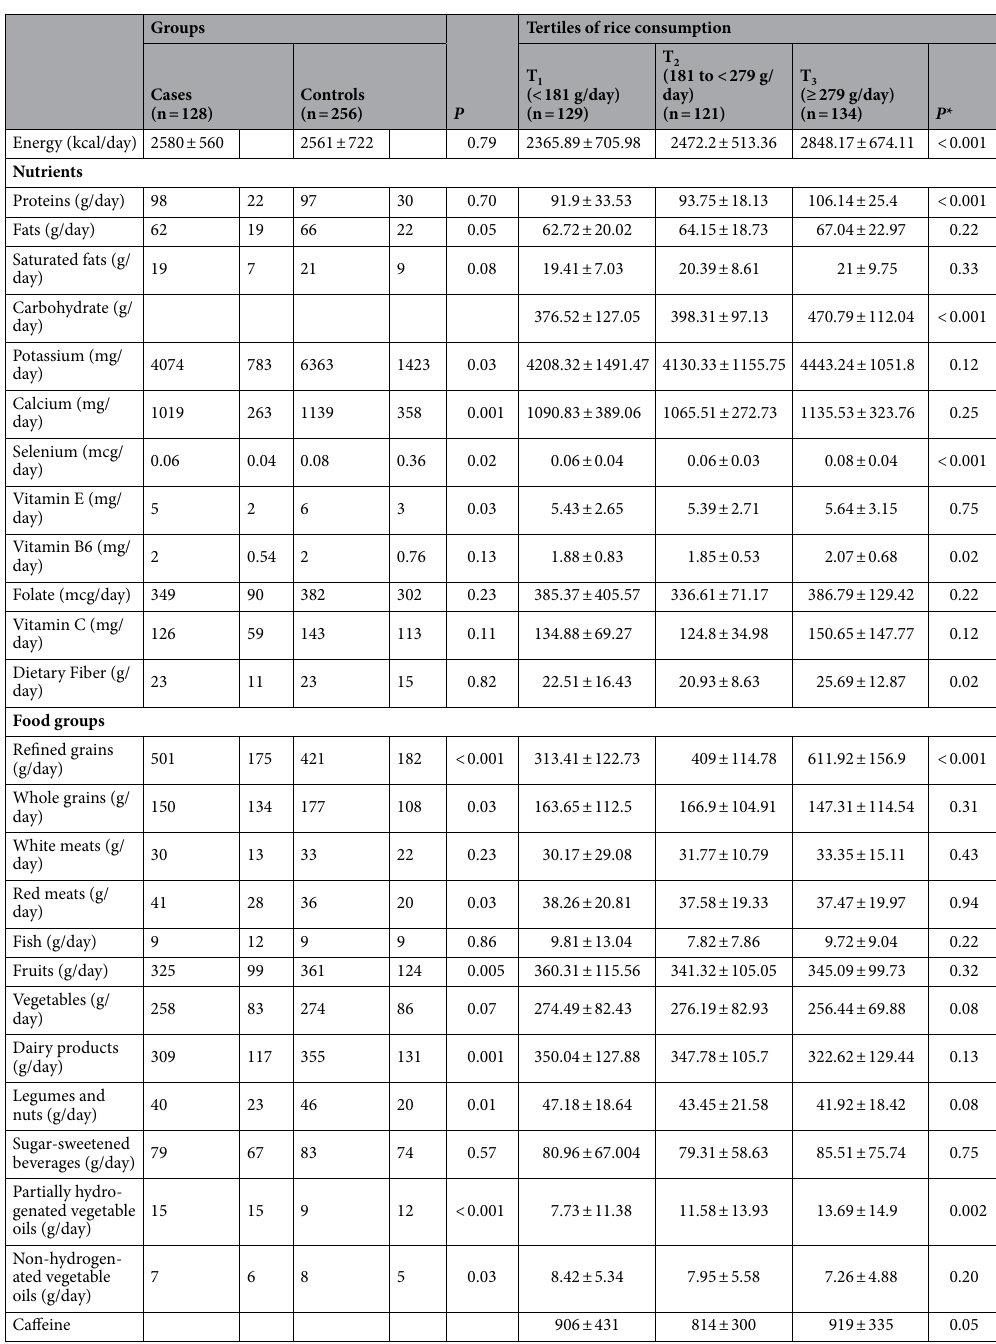
Table 2. Dietary and nutrient intake of study participants across tertiles of rice consumption. Data are presented as mean ± SD or percent. *Obtained from analysis of